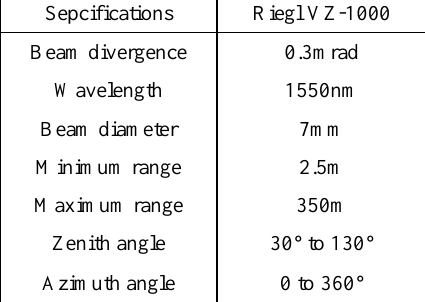
Table 1. Riegl VZ-1000 specifications